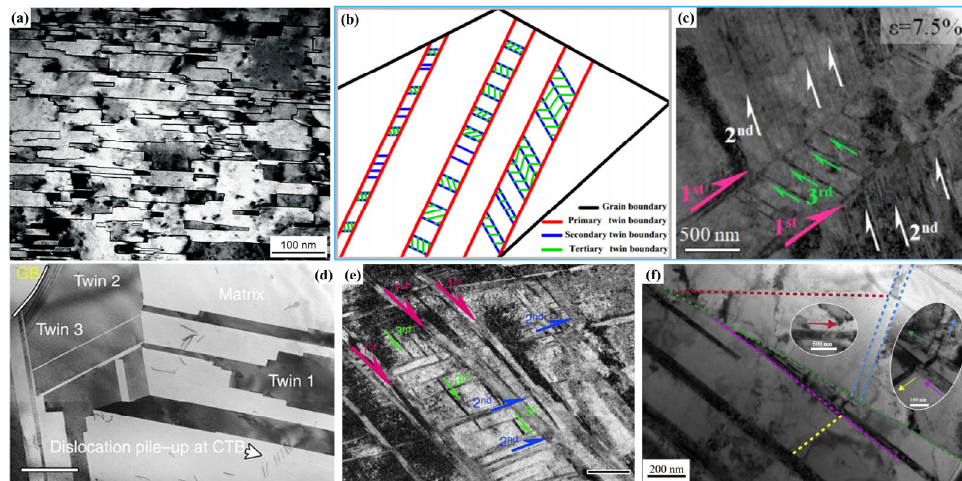
Figure 6. ( a ) TEM micrograph of the high ‐ density stepped nanotwins in single ‐ crystal Ni [117]; ( b ) a schematic of the HNT structure in Ti–4Mo–3Cr–1Fe alloy [121]; ( c ) TEM image of three ‐ orders HNT structure in CoCrFeMnNi alloy [122]; ( d ) the hierarchical twinning architecture in a grain of CrCoNi alloy [123]; ( e ) the three ‐ orders HNT structure in TWIP steel [120]; ( f ) TEM image of five ‐ orders HNT structures (the primary, secondary, tertiary, quaternary and quinary TBs are marked sequentially in red, blue, pink, yellow and green), and insets reveal the details of the corresponding ordered twins in the same colored arrows [124].